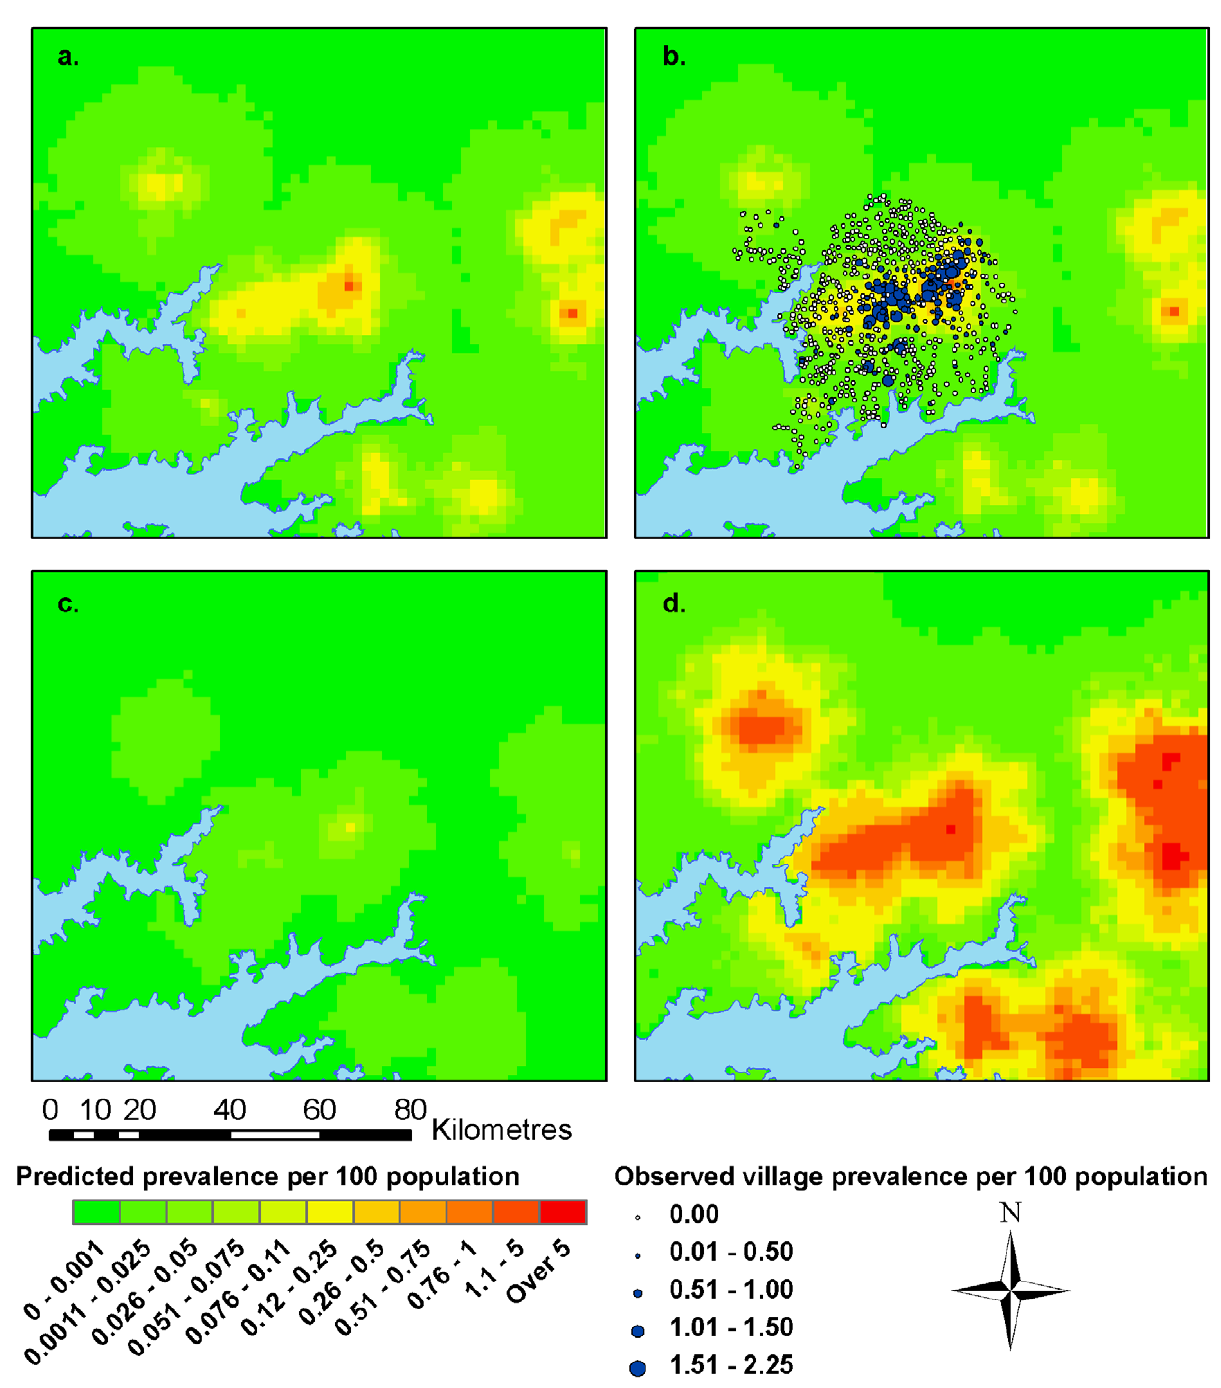
Figure 1. Predicted prevalence of HAT per 100 population from final spatial model. Predicted prevalence (1a), predicted prevalence with observed village prevalence (1b) and lower (1c) and upper (1d) 95% credible limits.